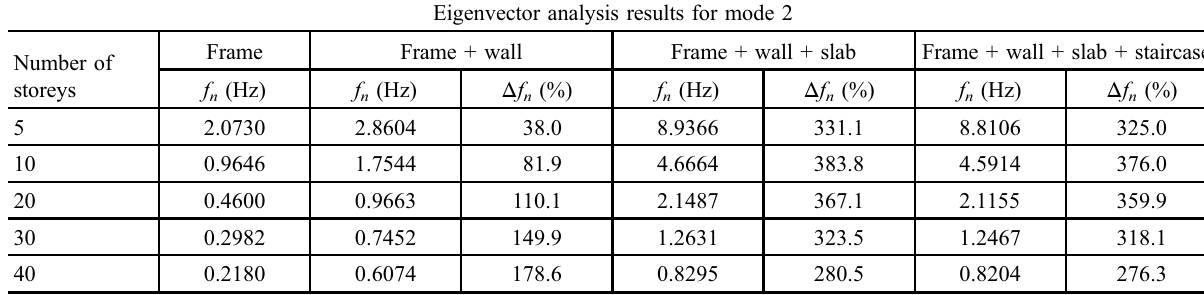
Eigenvector analysis results for mode 2